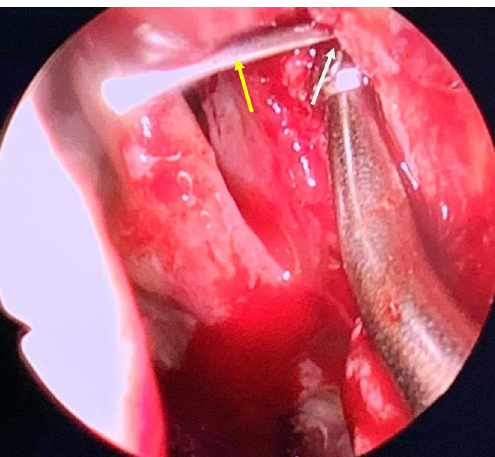
Figure 4. Intranasal view of opening of the lacrimal sac. A transcanalicular illuminator (yellow arrow) inserted through punctum being used to gain the location of lacrimal sac internally. The white arrow indicates the bony